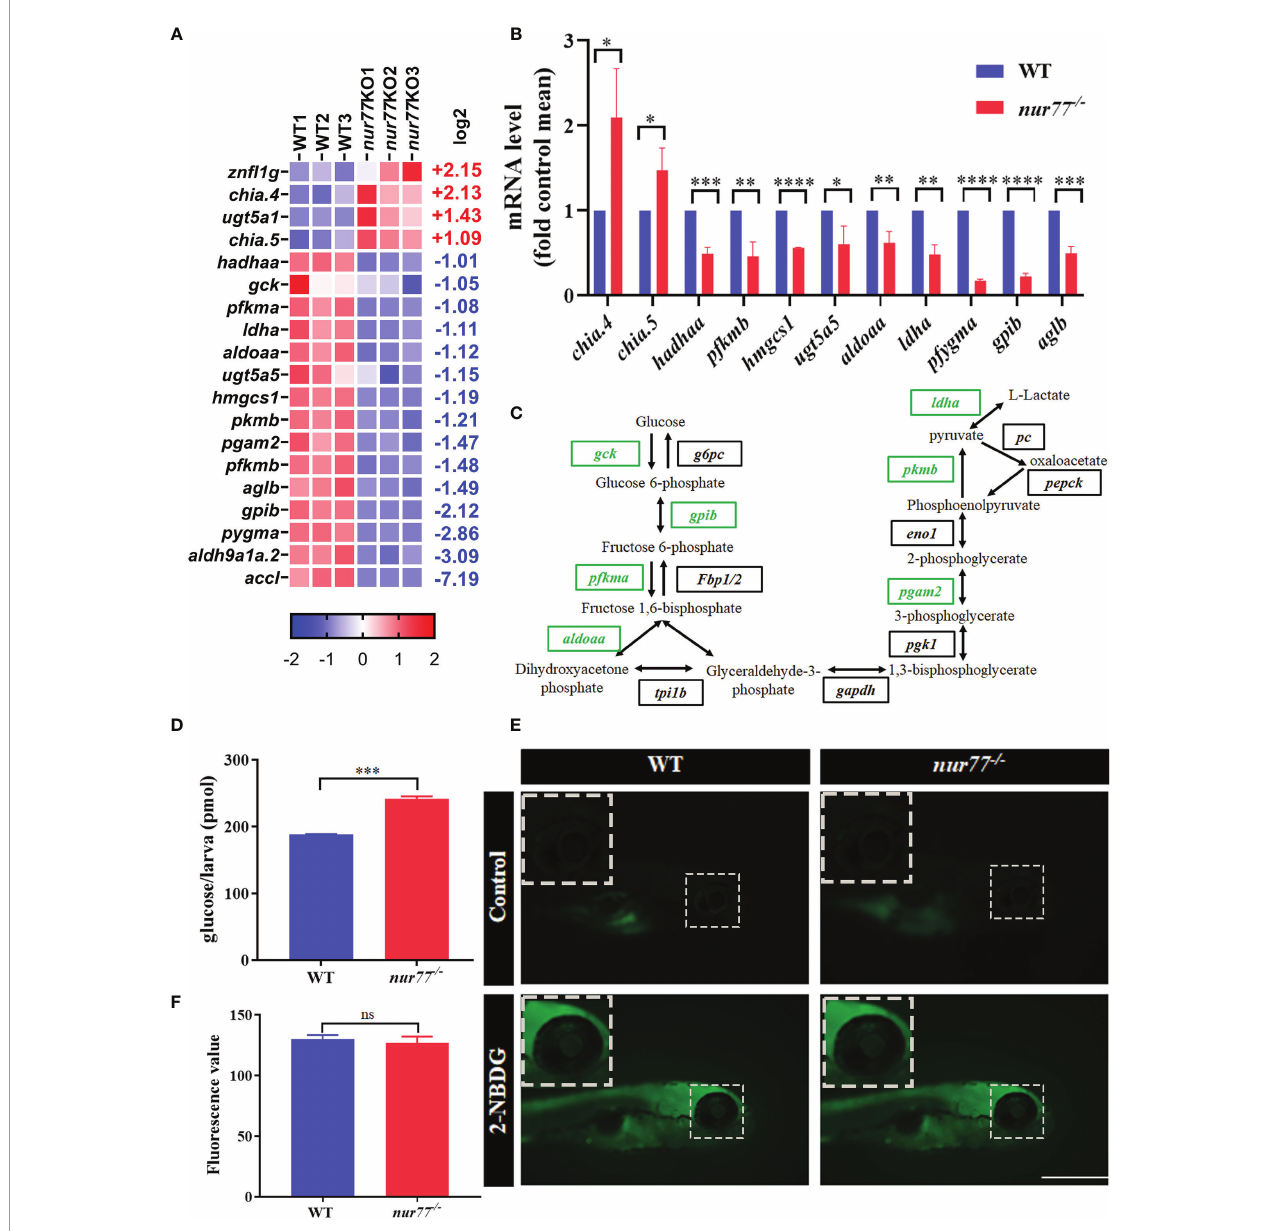
FIGURE 5 | Nur77 regulates carbohydrate metabolism in zebra fi sh larvae. (A) Heatmaps of transcripts in carbohydrate metabolism enrichment. Colors represent high (red), low (blue), or average (white) expression values based on Z-score-normalized fragments per kilobase per million mapped read (FPKM) values for each gene. The Z-score indicators are shown under each map. The fold change (log2) is shown on the right. (B) The validation of the expression levels of differentially expressed genes by qRT-PCR analysis in the categories of carbohydrate metabolism ( n = 3). (C) Disturbed glycolysis/gluconeogenesis. Blocks represent transcript- encoded enzymes. Green blocks represent downregulated genes, and black blocks represent unchanged genes. (D) The total free glucose contents of WT and nur77 − / − zebra fi sh ( n = 3). (E) 2-NBDG glucose uptake of wildtype and nur77 − / − mutant larvae; the glucose uptake level is indicated by the fl uorescence of lens (arrow) imaged by fl uorescent microscopy. Wildtype and nur77 − / − without 2-NBDG were used for control groups (upper panel). (F) Eye fl uorescence intensity was measured based on images. Quanti fi cation of fl uorescence intensity for WT and nur77 − / − zebra fi sh larvae. Results were represented as means with standard errors ( n = 3); ns, no signi fi cance; * p < 0.05, ** p < 0.01, *** p < 0.001, **** p < 0.0001 by t Figure 5D , the glucose level in nur77 − / − was signi fi cantly higher zebra fi sh led to the disorder of carbohydrate metabolism, especially in glucose metabolism. than wildtype. The increased free glucose may be due to To con fi rm the data from RNA-seq, we then measured the disordered glycolysis/gluconeogenesis, impaired glucose uptake, total free glucose in wildtype and nur77 − / − larvae. As shown in and decreased insulin secretion. Since the signaling pathway